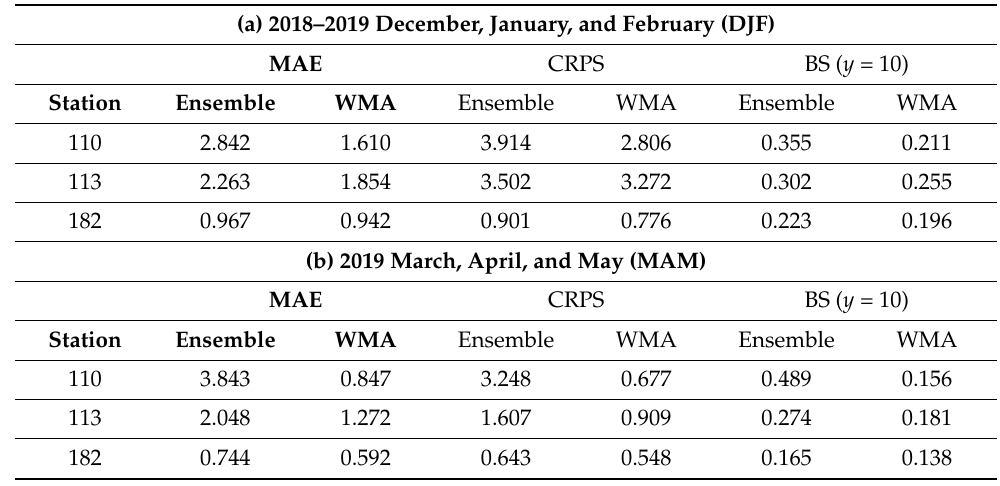
Table 6. Comparison of prediction skills of WMA and ensemble forecasts according to